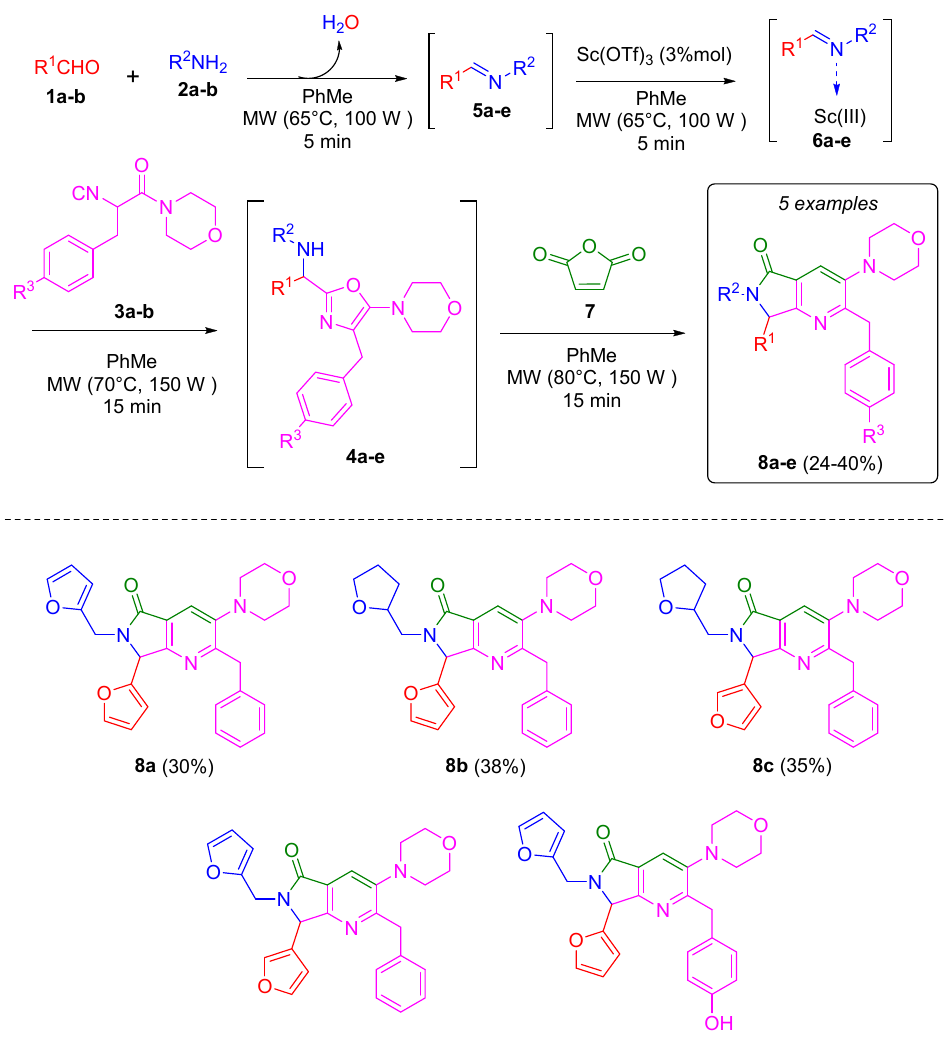
Scheme 2. Synthesis of pyrrolo[3,4- b ]pyridin-5-ones via a cascade process (Ugi-Zhu/ aza -Diels- Alder/ N -acylation/aromatization).